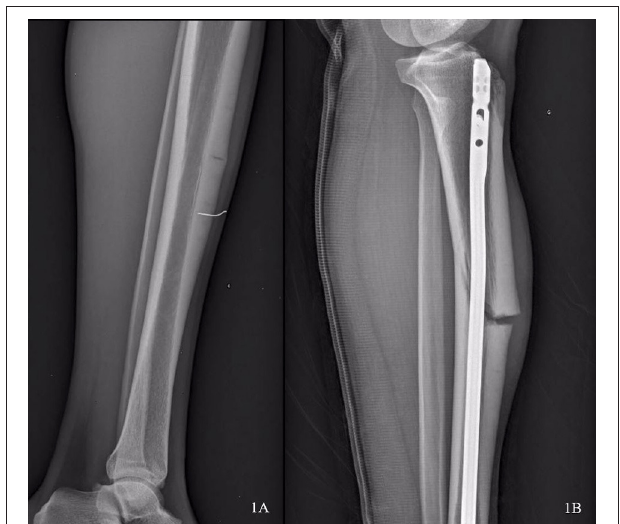
FIGURE 1 | Conventional radiography (profile) of the left limb showing the anterior tibial stress fracture with significant cortical thickening (A) and the complete anterior tibial fracture on pseudarthrosis with deformation of the intramedullary nail (B)